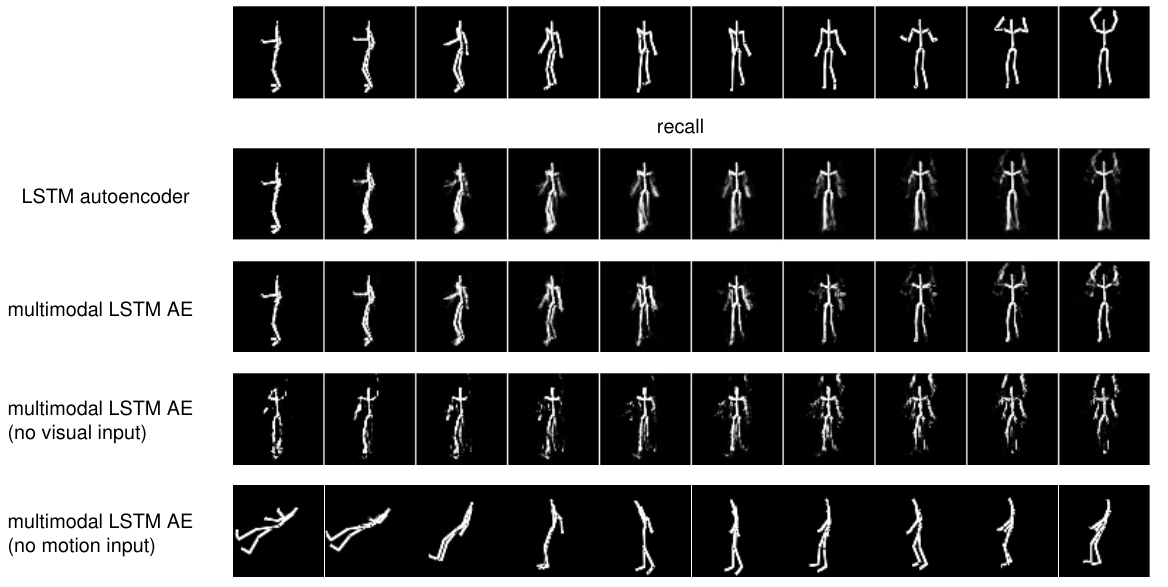
Figure 6: Examples of the target sequence, recalled visual images by LSTM autoencoder (AE) and multimodal LSTM AE, visual images recalled from only motion, and visualized motion sequences recalled from only vision (See the main text for the details).